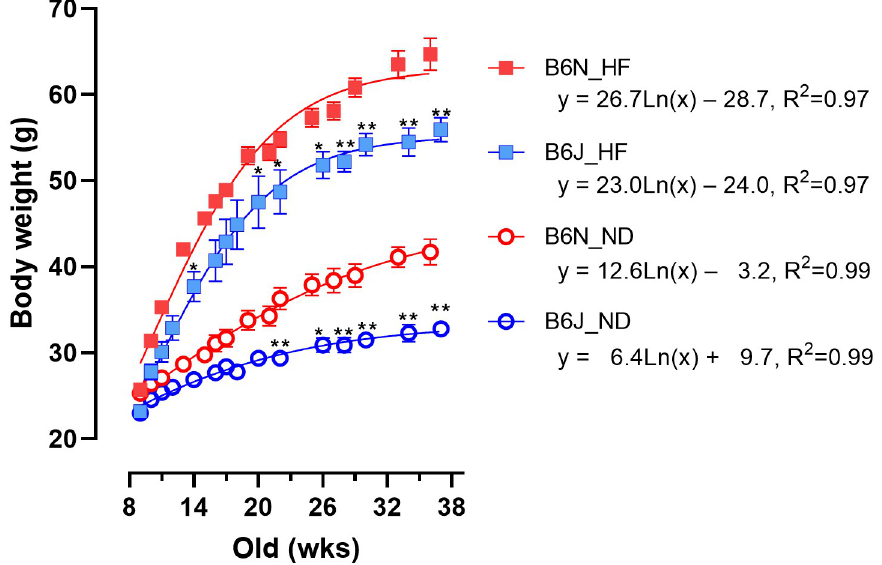
Fig 1. Difference in body weight between B6J and B6N mice on ND or HF. The body weight of male B6J and B6N mice on ND or HF was monitored up to 38 weeks of age (n = 5 per group). Data are presented as mean ± SEM.